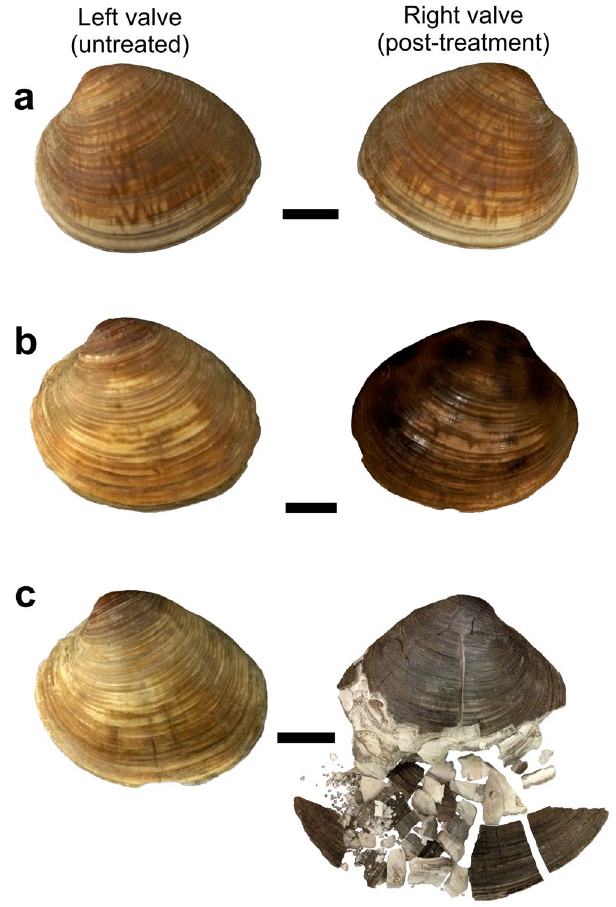
Figure 1. Visual comparison of untreated left valves and the corresponding right valves exposed to the different treatments prior to hydrogen peroxide cleaning. ( a ) Boiling for 40 minutes. ( b ) Roasting for 240 minutes. ( c ) Burning for 240 minutes. Scale bars represent 1.0